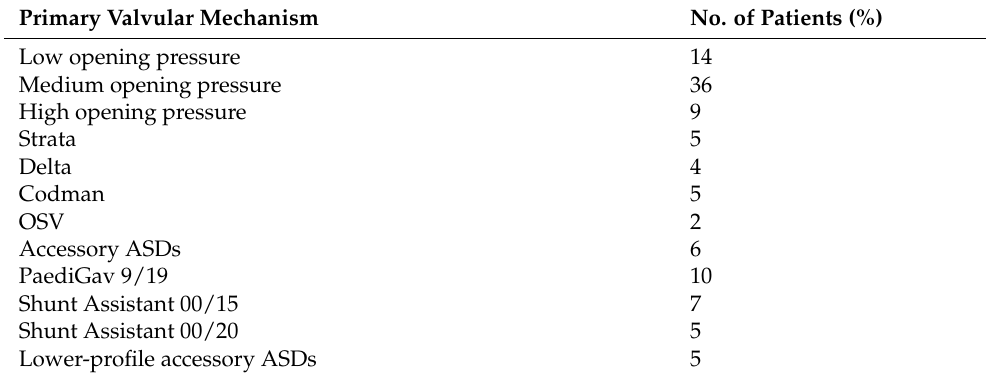
Table 2. Types of primary valvular mechanisms and